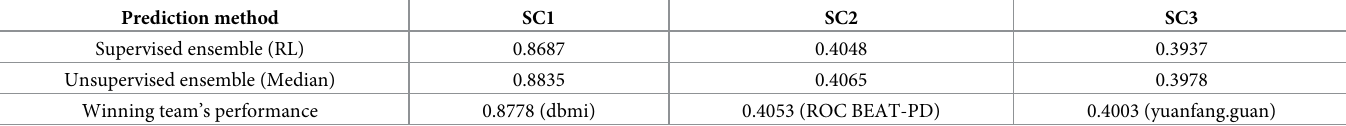
Table 1. Prediction performance (weighted MSE) of the final supervised and unsupervised ensemble methods on the SC1-3 test sets. For reference, the performance and name of the winning team in each sub-challenge are also shown. Prediction